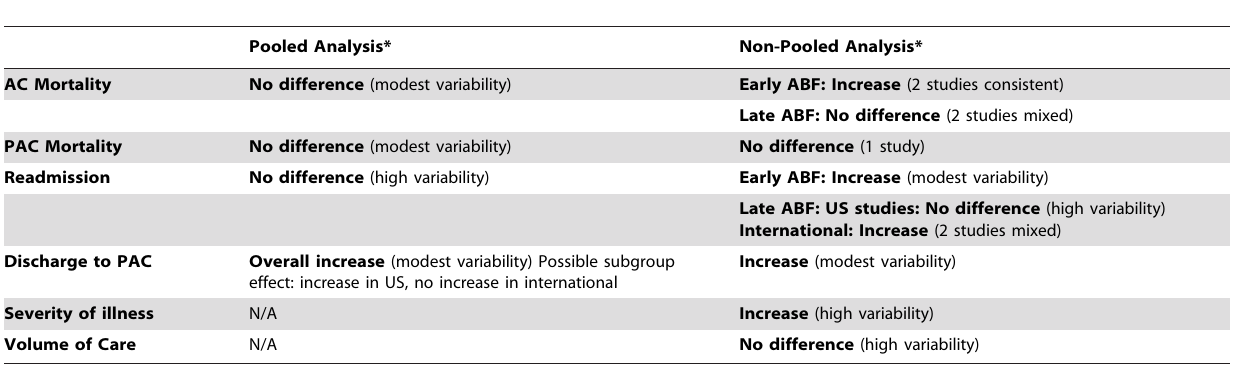
Table 2. Summary of Findings of the Impact of ABF (Pooled and Non-Pooled).